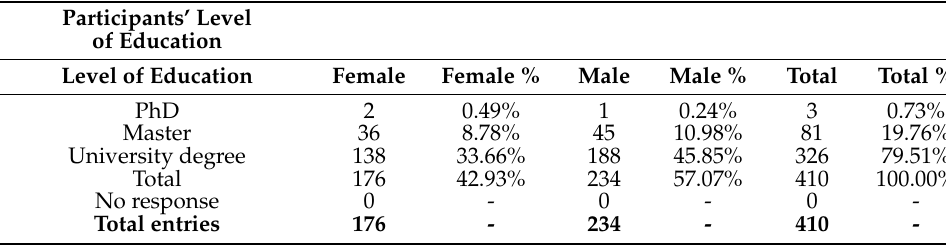
Table 4. Level of studies of the sample participants combined with